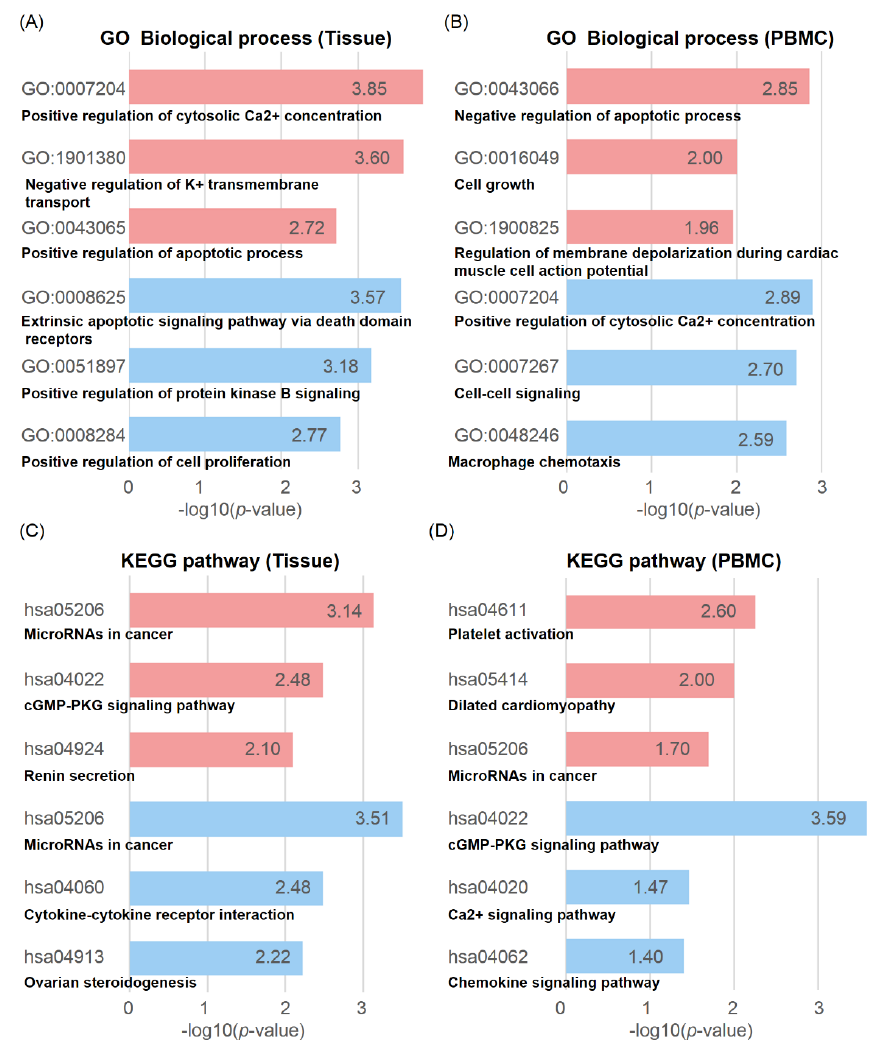
Figure 3. Enrichment analysis of gene ontology (GO) and KEGG pathway using DMGs in CMT. Gene ontology (GO) and KEGG pathway analysis in tissue and PBMC DMGs are depicted with −log ( p -value), where the y -axis represents terms and IDs. From tissues, 139 hyper- and 202 hypomethylated DMGs, and, from PBMCs, 72 hyper- and 175 hypomethylated DMGs were applied. The top three significant GO_BP terms are depicted. Colors represent hyper (red) and hypo (blue) methylations. GO analysis in biological processes in tissues ( A ) and in PBMCs ( B ). KEGG pathway analysis in tissues ( C ) and PBMCs ( D ). KEGG: Kyoto encyclopedia of genes and genomes; DMG: differentially methylated gene; BP: biological process; CMT: canine mammary tumor; di ff erentially methylated